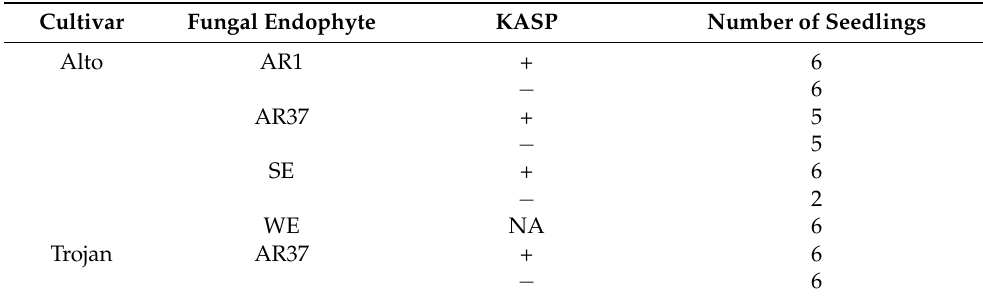
Table 1. Cultivar/ E . festucae var. lolii combinations of L. perenne Single Seed accessions. Cultivar Fungal Endophyte KASP Number of Seedlings Alto